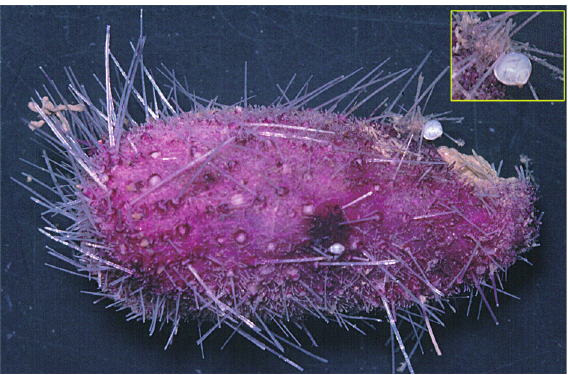
Fig. 9. Pourtalesia miranda Agassiz, 1869 with Syssitomya pourtalesiana sp. nov. attached, from Biscay. Courtesy of A.J. & E.C.